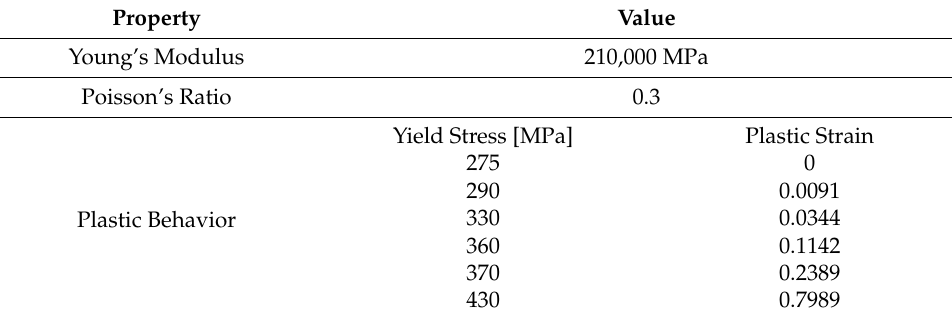
Table 3. Structural Steel S 275 mechanical